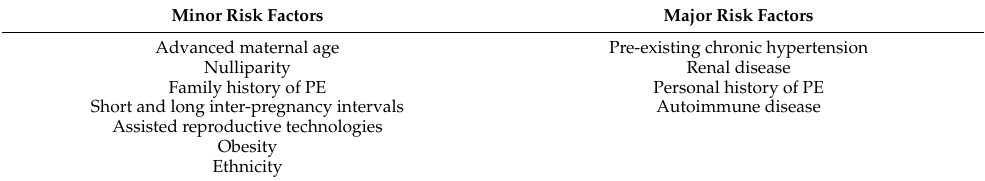
Table 2. Risk factors for pre-eclampsia (PE).